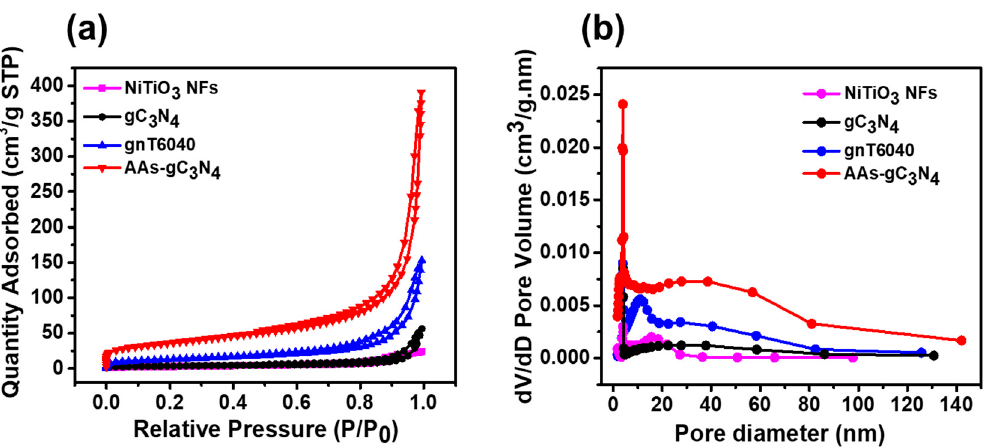
Figure 4. Brunauer-Emmett-Teller (BET) specific surface areas. ( a ) N 2 adsorption-desorption isotherms and ( b ) pore size distribution of NiTiO 3 NFs, gC 3 N 4 , AAs-gC 3 N 4, and gnT6040.